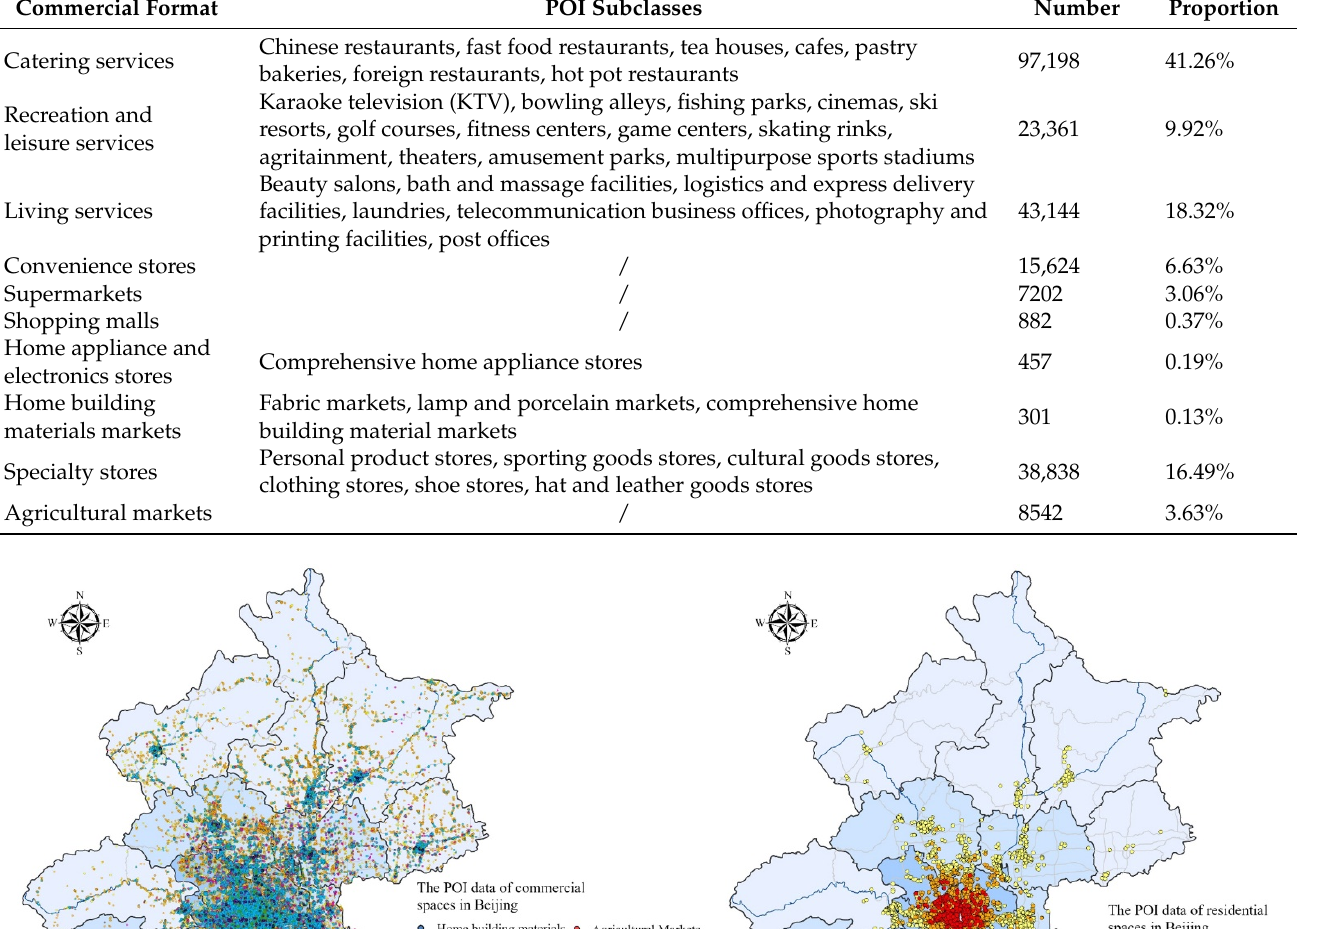
Table 1. Classification of commercial formats.